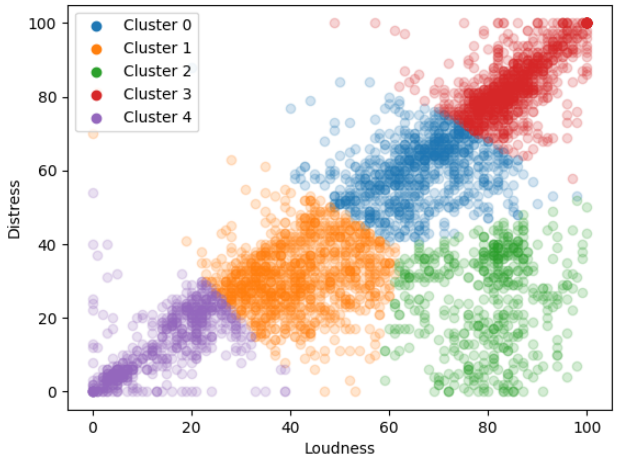
Figure 4. The 5 clusters of loudness/distress